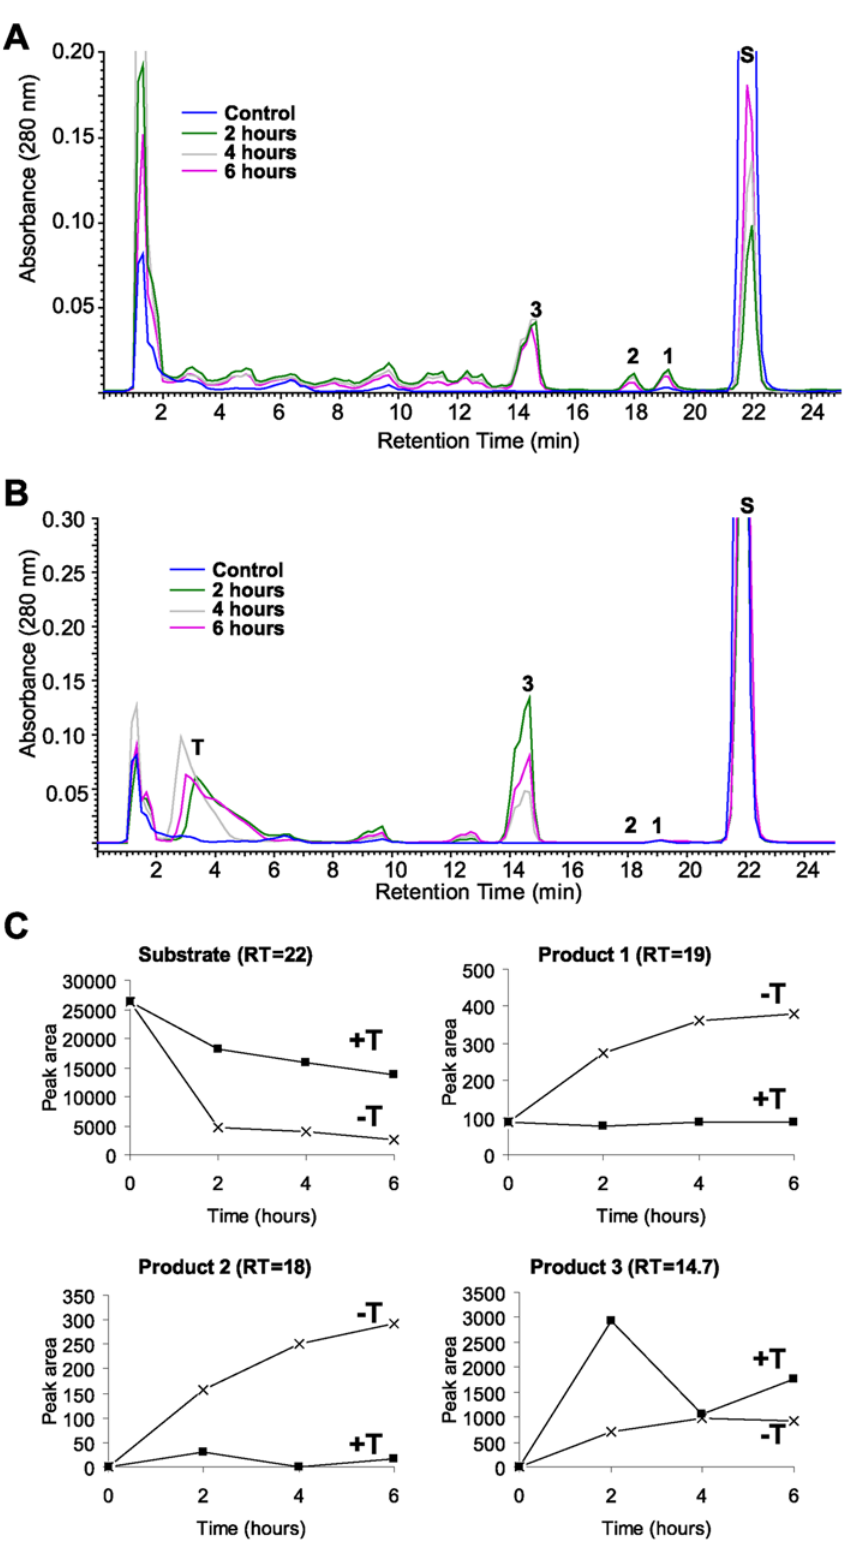
Figure 6. Time-dependent metabolism of 7DHP is modified by trilostane (T). Fragments of the pig adrenal glands were incubated with 7DHP (S; 0.5 mM) in the absence ( A ) or presence ( B ) of trilostane (0.1 mM) and analyzed by RP-HPLC. Boiled adrenal fragments were used as a negative control ( blue ). The major products of 7DHP metabolism affected by trilostane are marked by numbers. Time-dependent changes in the relative concentration of the identified products in presence (T + ) or absence (T-) of trilostane were calculated using ACDLabs software and are presented in C .